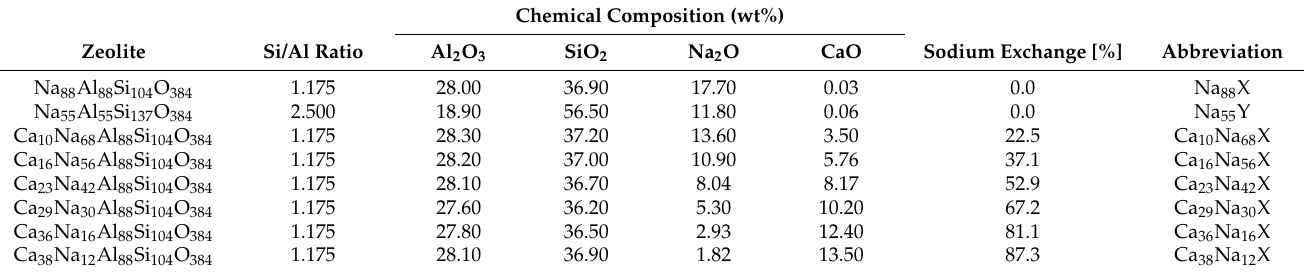
Table 3. Chemical properties of zeolite materials (Determined by XRF (X-ray fluorescence spectroscopy)). Chemical Composition (wt%) Zeolite